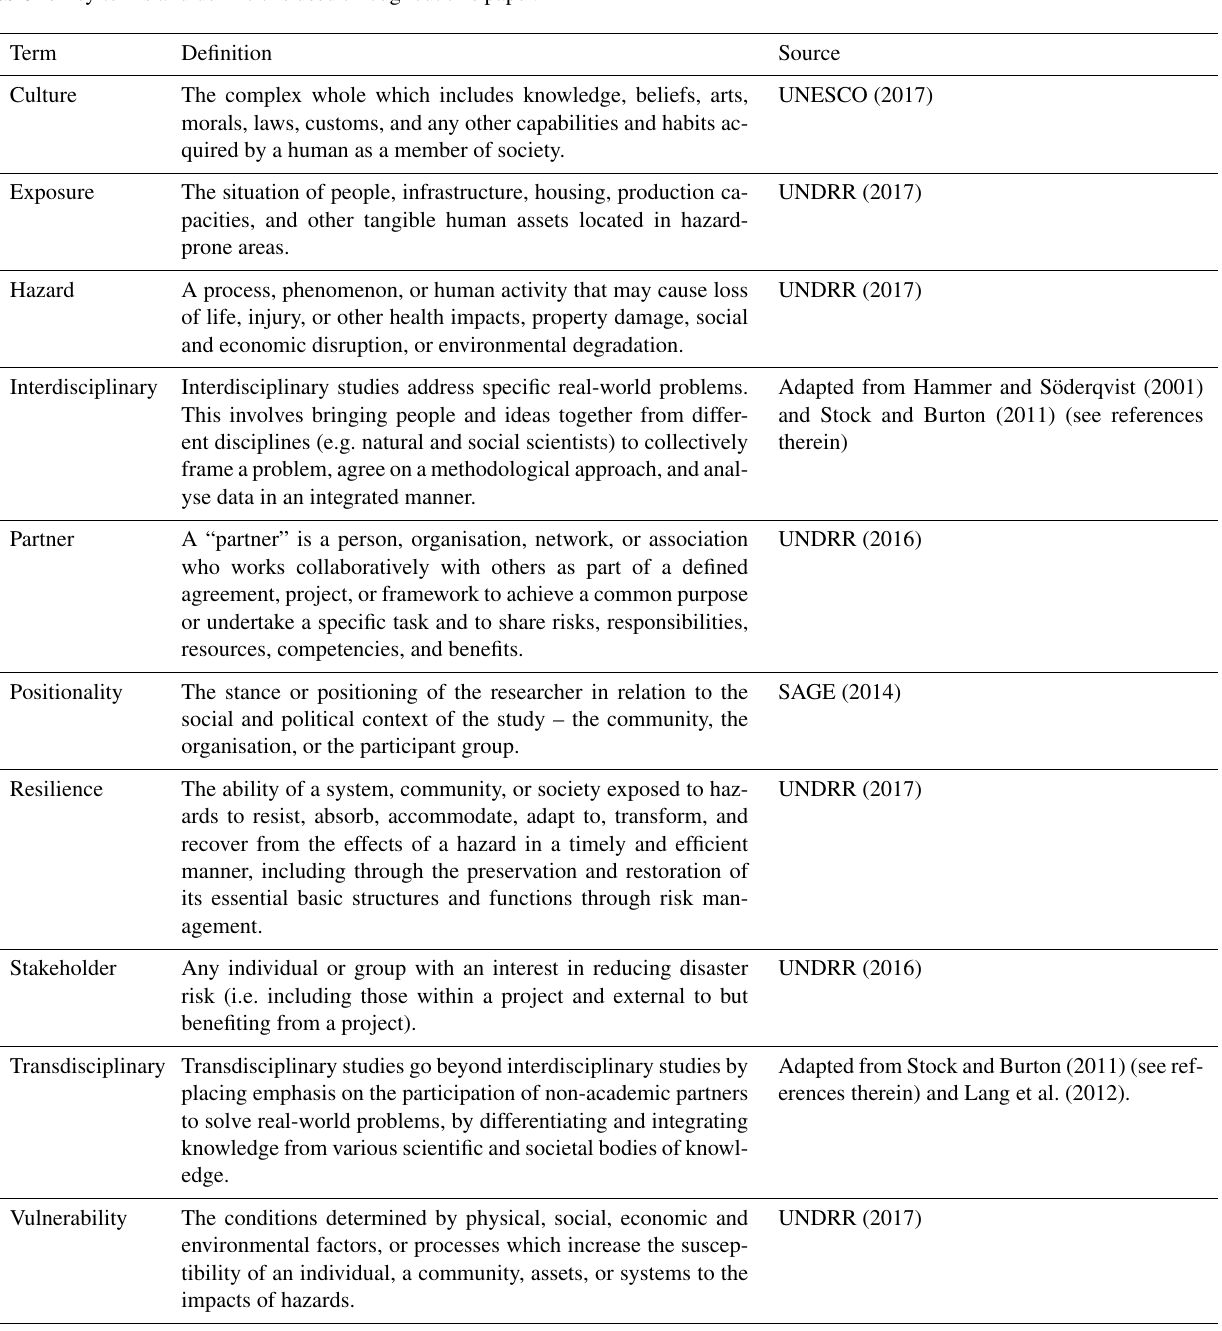
Table 1. Key terms and definitions used throughout this paper.